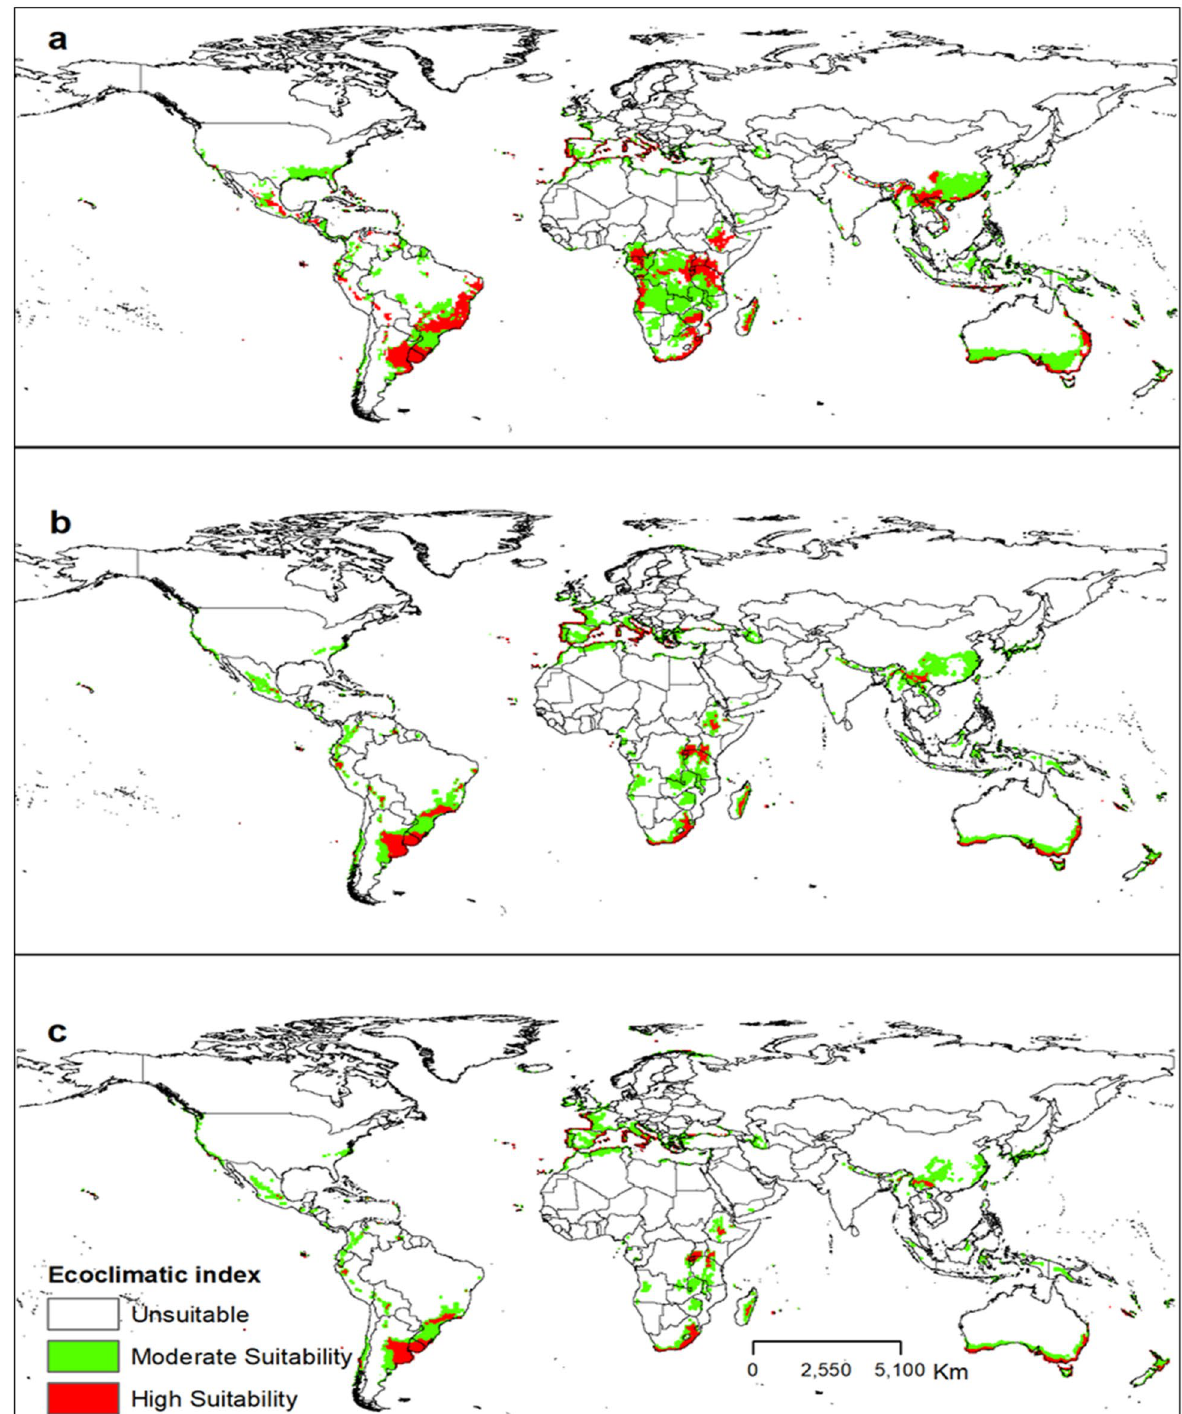
Figure 4. The Ecoclimatic Index (EI) for Trioza erytreae using CLIMEX running the SRES A1B scenario for the current time ( a ), 2050 ( b ) and ( c ) 2070. ESRI ArcMap 10.2.2 (https:// suppo rt. esri. com/ en/ Produ cts/ Deskt op/ arcgis- deskt op/ arcmap/ 10-2- 2# downl oads) and CLIMEX 4.0.0 (https:// www. hearne. softw are/ Softw are/ CLIMEX- DYMEX/ Editi